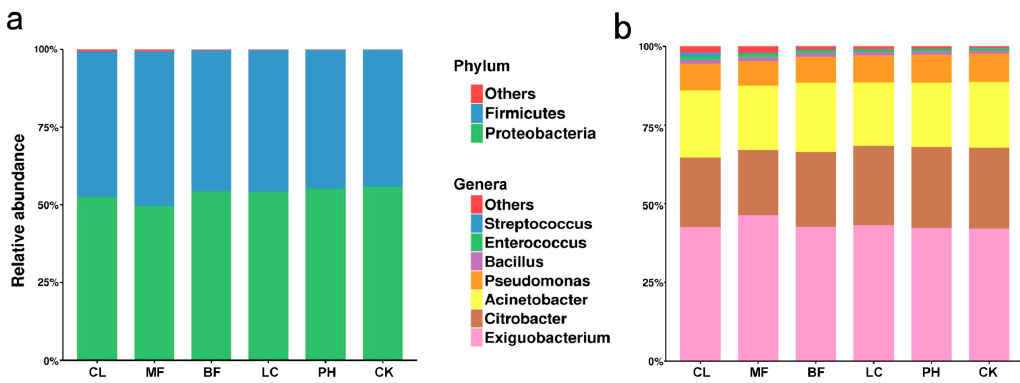
Figure 3. Relative abundance of airborne bacteria in each vegetation-covered forest at the ( a ) phylum and ( b ) genus levels.